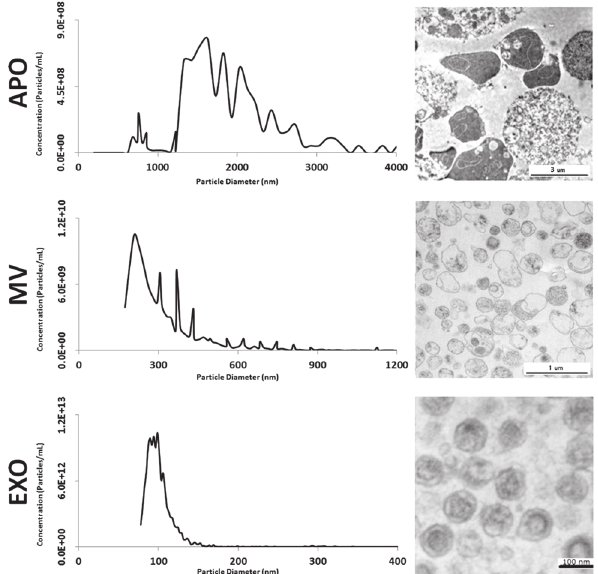
Fig 1. Characterization of EV subpopulation size and morphology. Apoptotic bodies (APO), microvesicles (MV) and exosomes (EXO) were isolated from conditioned tissue culture supernatant of BV-2 cells. Size distributions of the different subpopulations were assessed by tunable resistive pulse sensing (qNano) using three different membranes (NP200, NP400, and NP2000). Obtained particle concentrations were merged into single histograms for each EV subpopulation (left panels). Electron microscopic images of respective EV subpopulation pellets are shown (right panels).